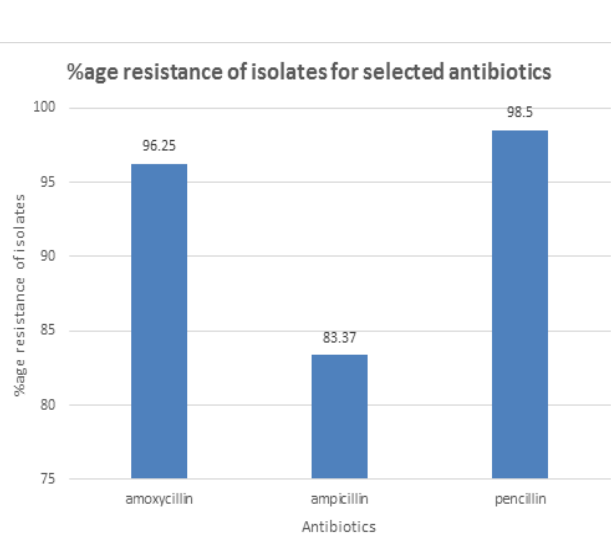
Fig. 12 The resistance of antibiotics